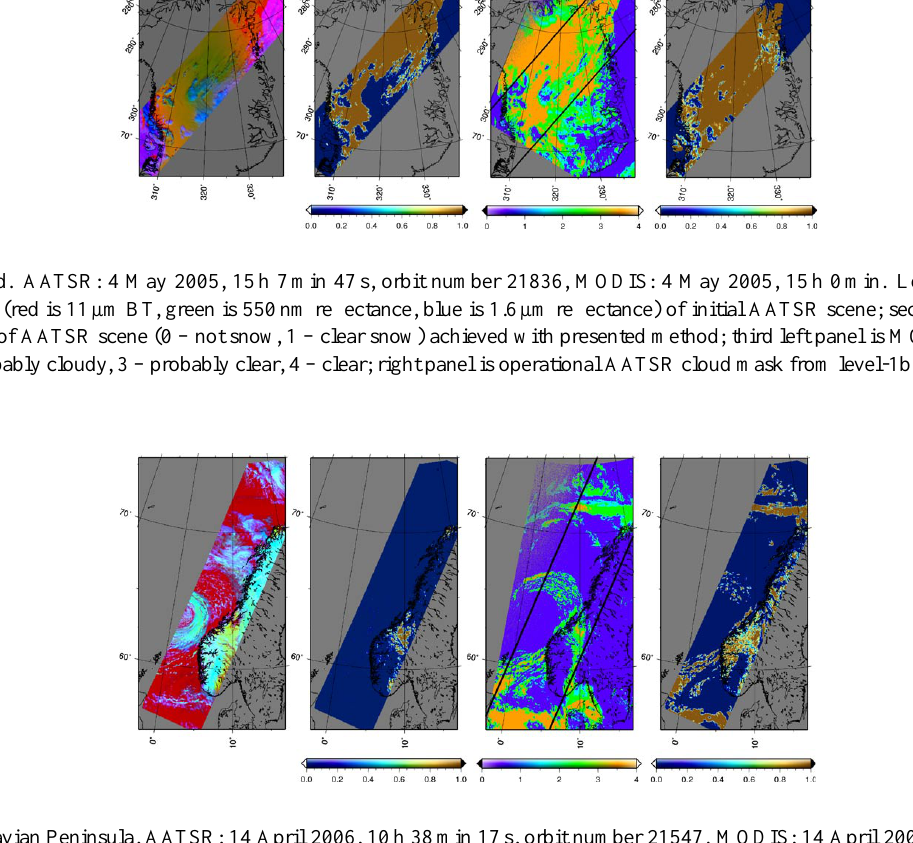
Fig. 8. Alaska, AATSR: 30 April 2006, 22h 17min 44s, orbit number 21783. MODIS: 30 April 2006, 22h 5min. Left panel is the false colour composite (red is 11µm BT, green is 550nm reflectance, blue is 1.6µm reflectance) of initial AATSR scene; second left panel is the clear snow mask of AATSR scene (0 – not snow, 1 – clear snow) achieved with presented method; third left panel is MODIS cloud mask: 1 – cloudy, 2 – probably cloudy, 3 – probably clear, 4 – clear; right panel is operational AATSR cloud mask from level-1b product: 0 – cloudy, 1 – clear.